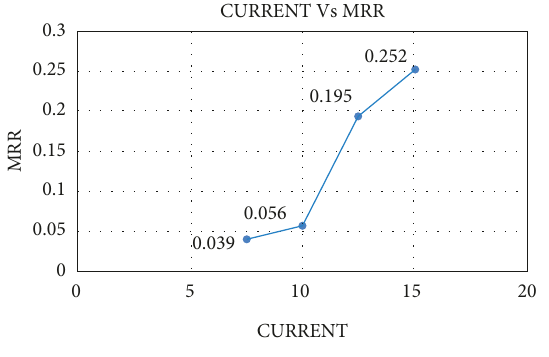
Figure 5: Current versus MRR.